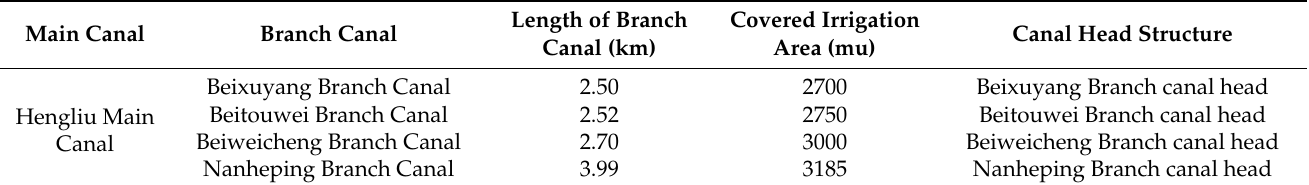
Table 2. Basic information of each of the branch canals in the Hengliu Main Canal system.